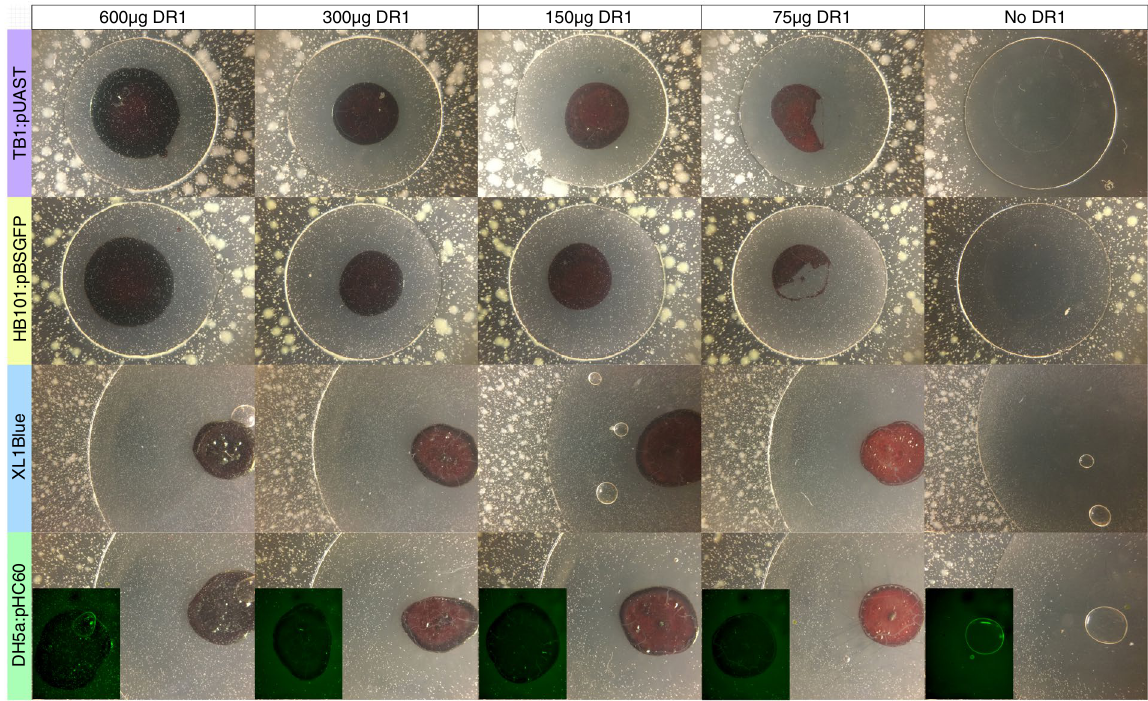
Figure 3. Antibiotic capture with DR1/PMMA. All coverslips have been prepared with 0.625 µ g tetracycline (top two rows) or 2.5 µ g ampicillin (bottom two rows) supplemented with the mass of DR1/PMMA indicated at the top of each column. Inset pictures in the bottom row show alternative visualization using GFP fluorescence. See Fig. 1 to identify